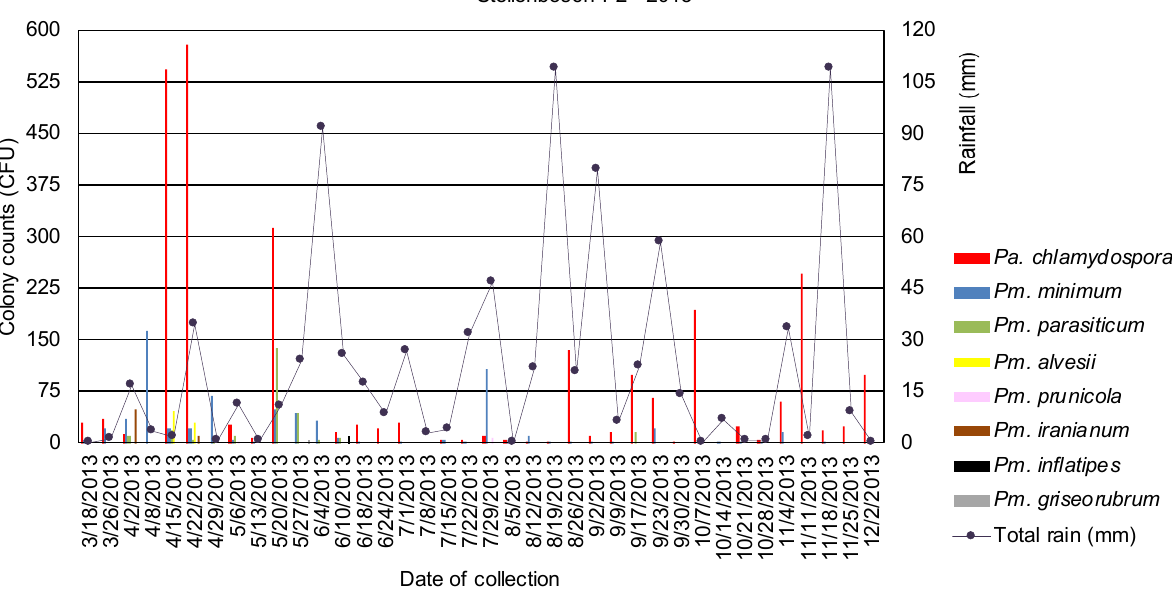
Figure 8. Phaeomoniella and Phaeoacremonium spp. cfu cultured from five vaseline coated microscope slides affixed to the cordons on each of five vines in vineyard Stellenbosch P2, Western Cape province in 2013. The slides were replaced weekly. Each bar represents the total number of cfu cultured on three Petri dishes. Not clear on the graph, detection dates for Pm. prunicola are 06/05 and 29/07 and for Pm. griseorubrum is 27/05.